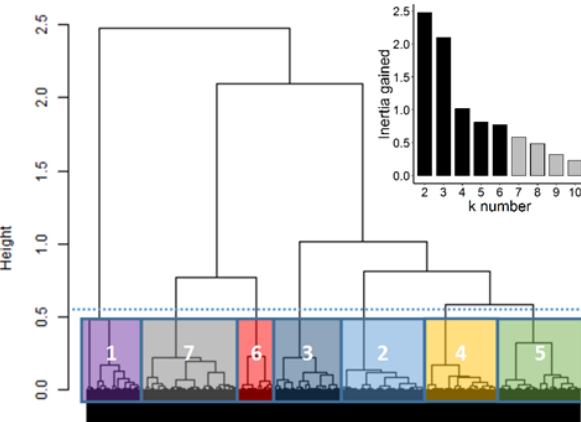
Figure 4. Dendrogram resulting from the hierarchical cluster anal- ysis of principal components. The blue, dashed line indicates the cut in the tree, resulting in seven clusters. The amount of inertia gained by increasing the number of clusters ( k ) is depicted in the inset